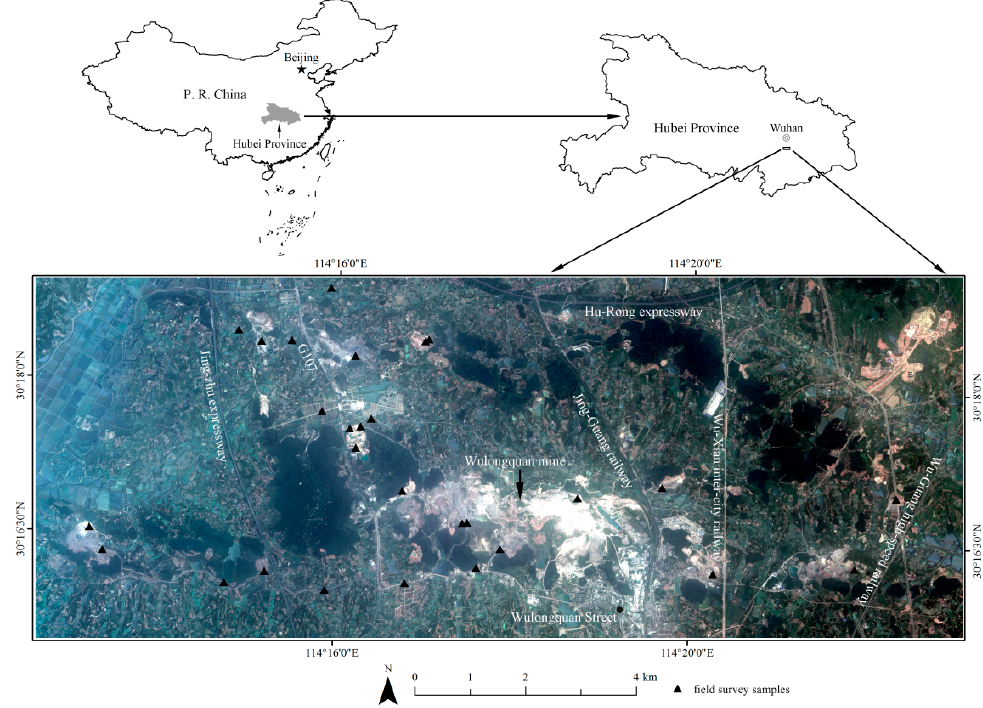
Figure 1. Location of the study area and field survey samples, and ZiYuan-3 fused true color image (R, Red; G, Green; B, Blue) [14]. Jing-Zhu expressway: connecting Beijing and Zhuhai; G107: national highway 107 of China; Hu-Rong expressway: connecting Shanghai and Chengdu; Jing-Guang railway: connecting Beijing and Guangzhou; Wu-Xian inter-city railway: connecting Wuhan city and Xianning of Hubei Province, China; Wu-Guang high-speed railway: connecting Wuhan and Guangzhou.